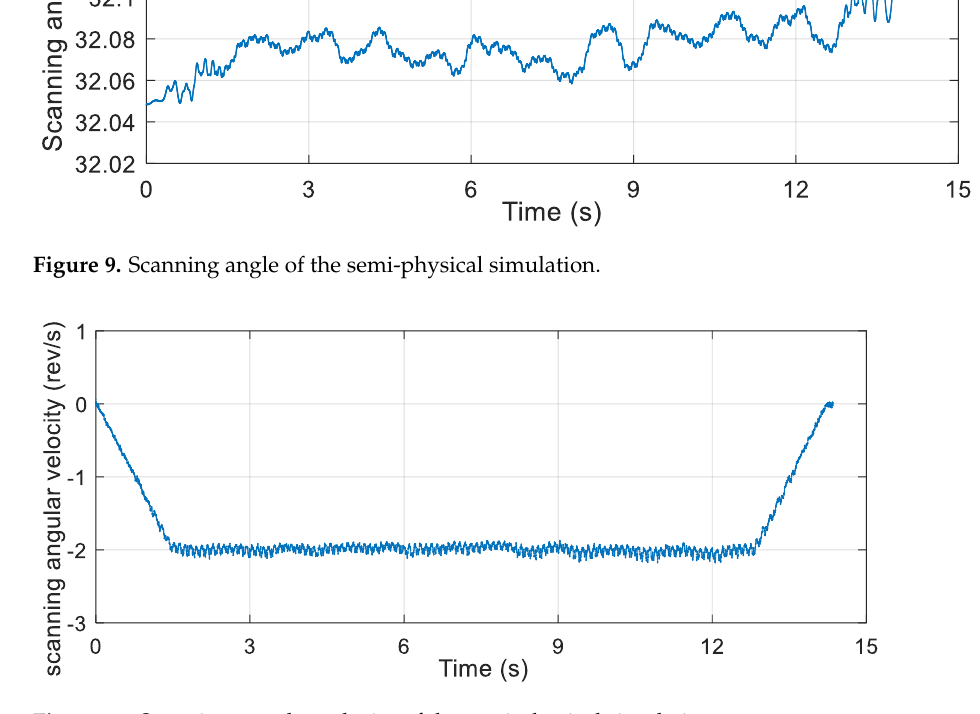
Figure 10. Scanning angular velocity of the semi-physical